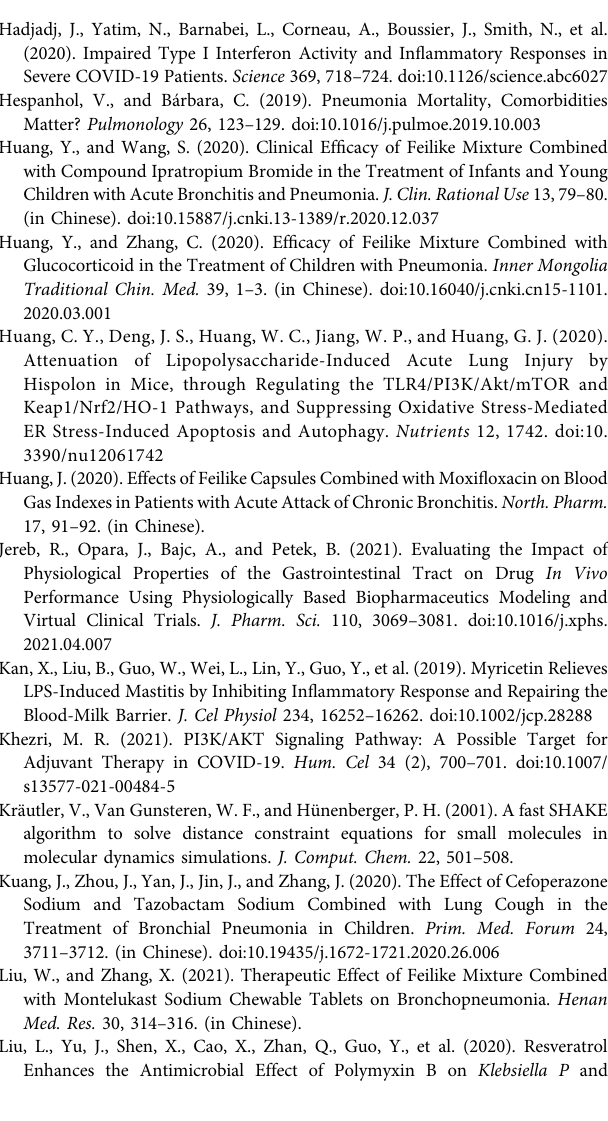
Supplementary Figure S1 | Overlapped targets were subjected to GO enrichment analysis. SupplementaryFigureS2| KEGGenrichmentanalysisfor115overlappedtargets. (A) Overlapped targets were subjected to KEGG pathway analysis. (B) KEGG pathways were categorized in the level of class 2. Supplementary Figure S3 | Modular Analysis. Gene clusters of four functional modules by community cluster (Glay) algorithm (left). The color and size of a node represent the degree value of a target in the network. The point-and- fi gure chart showsthetop fi